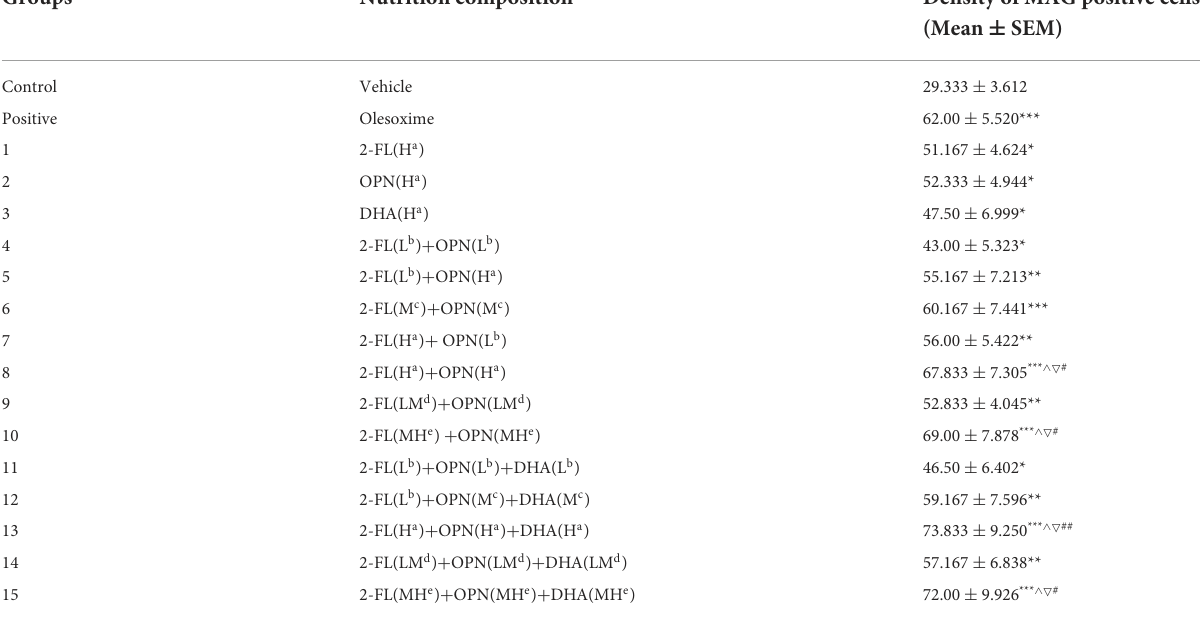
TABLE 3 Effects of different nutritional compositions containing 2’-FL, OPN and/or DHA on the number of MAG positive